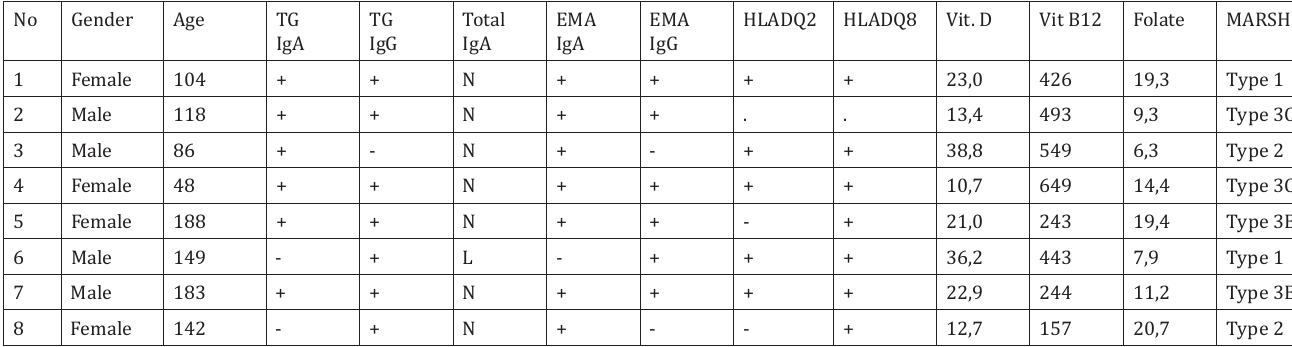
Clinical characteristics of CD